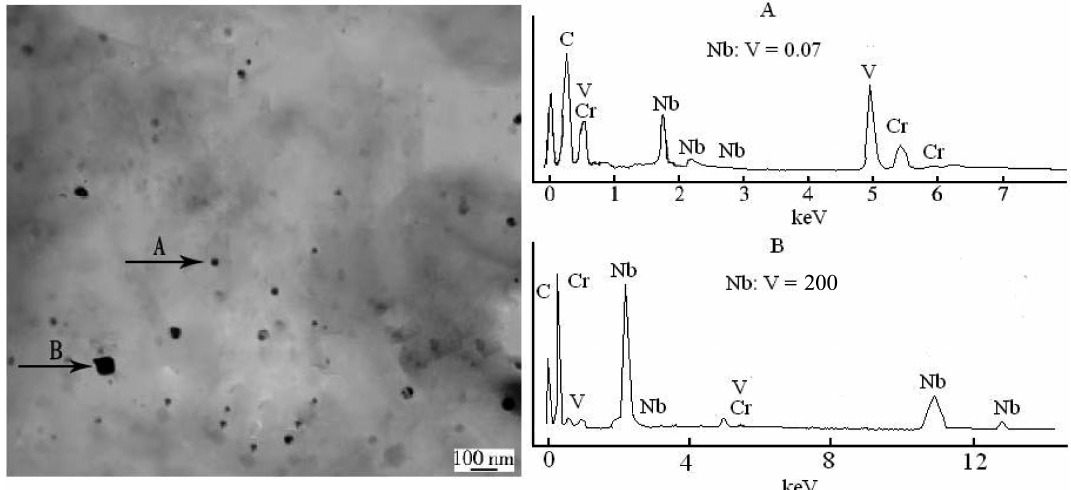
Fig. 5: TEM micrograph and EDX spectra of carbonitride